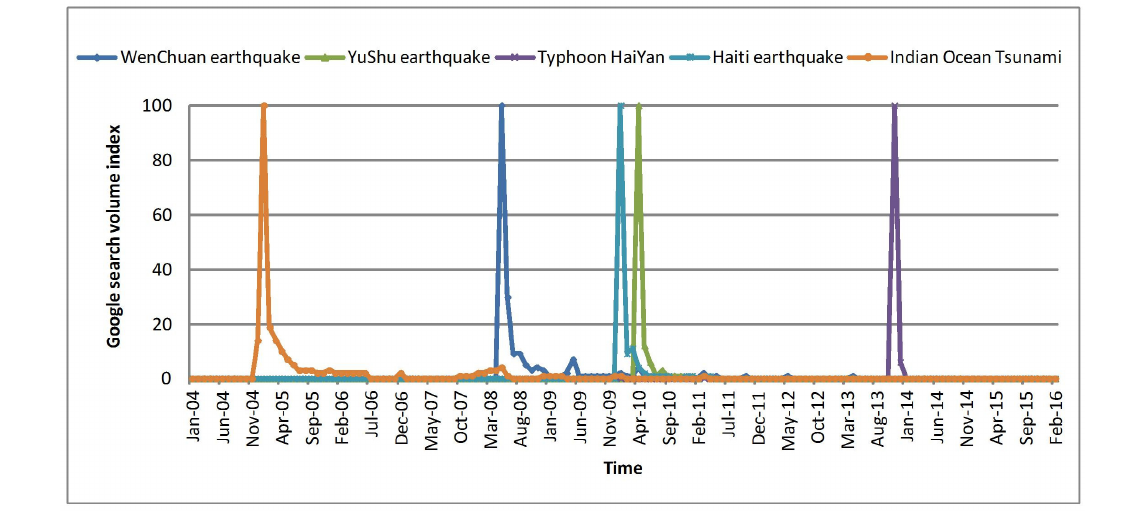
Figure 3. Examples of Google Trends. Table 1. Comparisons between the detected and actual start